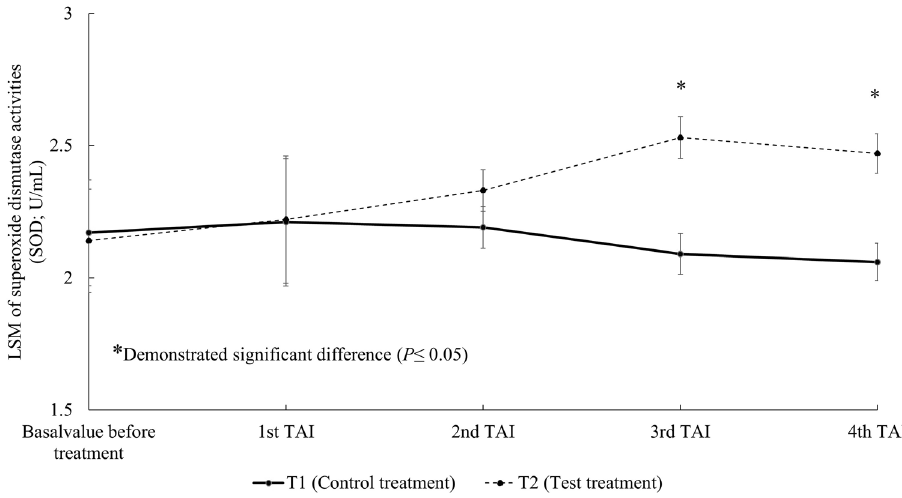
Figure 5. Least-squares means (LSM) of superoxide dismutase activities (SOD; U/mL) in milk at the same time of each timed artificial insemination (TAI). T1 = Control treatment, T2 = Test treatment.